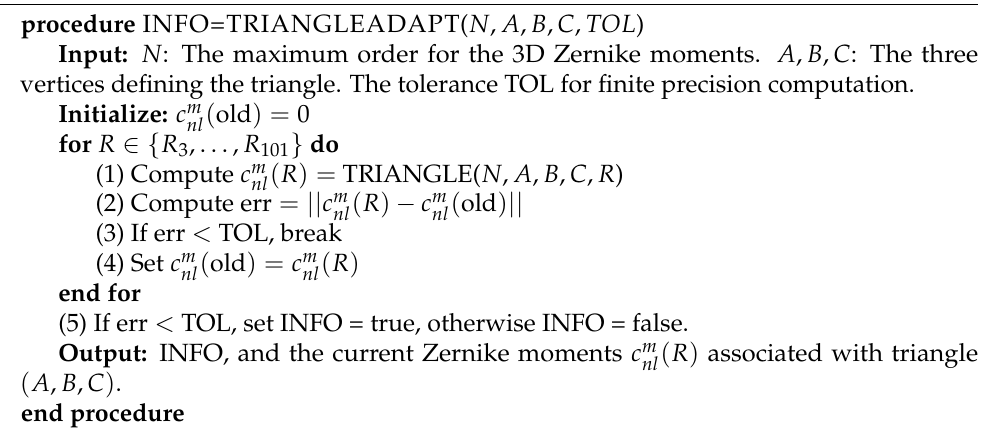
Algorithm 4 Adaptive computation of Zernike moments associated with one triangle of a sur- face